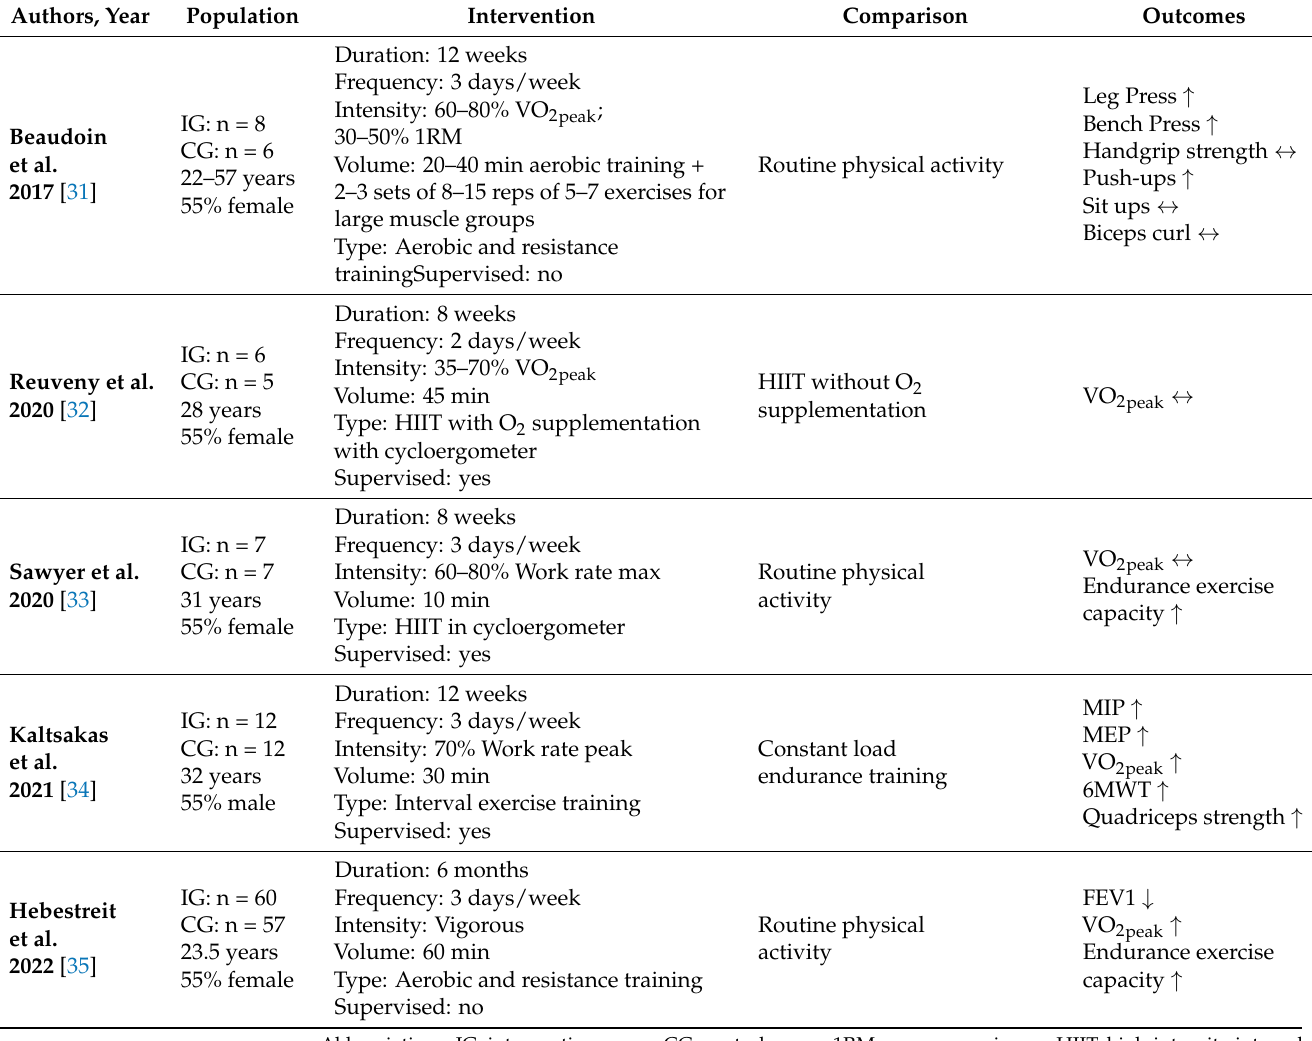
Table 2. Outcomes from physical exercise interventions on adults with cystic